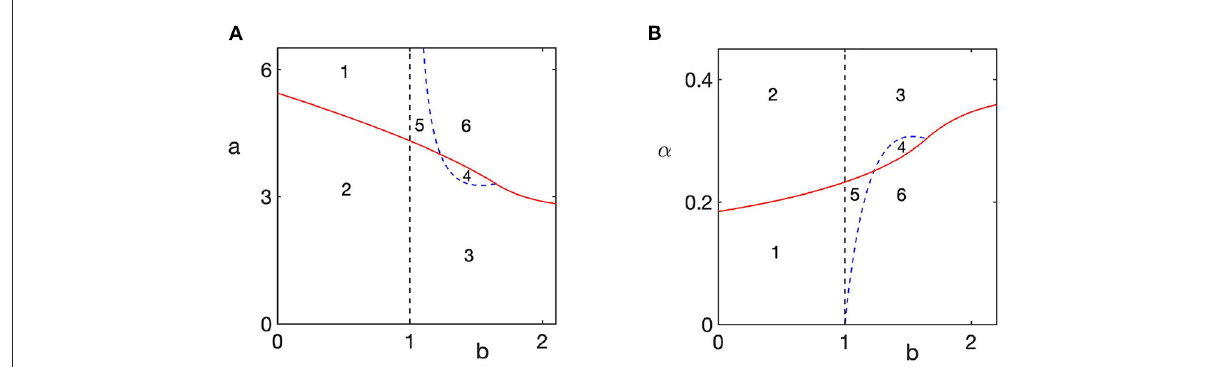
FIGURE3 Regions of feasibility and stability of different steady states of the model (Equation 4). The prey-only steady state E = (1,0) is stable to the left of the dashed black line at b = 1, and unstable to the right of that line. The extinction steady state E 0 is stable above red line in plot (A) and below red line in plot (B) . In region 1, there is bi-stability between a stable steady state E and the extinction steady state E 0 ; in region 2 only the steady state E is stable; in region 3, only the coexistence steady state E ∗ is stable; in region 4, the coexistence steady state E ∗ is unstable, and there is periodic orbit around this state; in region 5, there is bi-stability between the extinction steady state E 0 and the coexistence steady state E ∗ ; in region 6, only extinction steady state E 0 is stable. Parameter values are α = d = 1 (A) , a = d = 1 (B) .